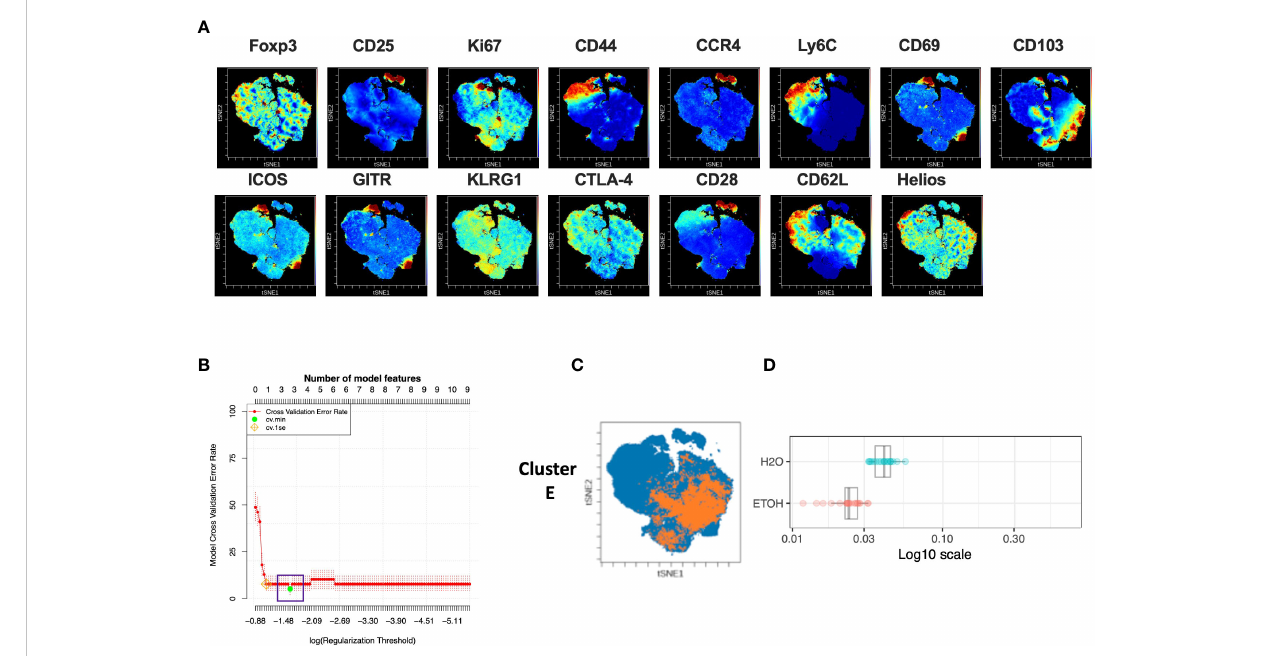
FIGURE 6 Combined CITRUS and viSNE analysis revealed one CD8 + T cell cluster associated with alcohol-drinking mice. (A) CD8 + T cell subset samples from the modeling cohort were equally downsampled to 20000 events to detect 2% subpopulations with CV=5%. 1 water drinking sample was excluded due to insuf fi cient event count. viSNE mapping was performed using all 15 available markers for clustering (CD3, CD4 and CD8 were excluded). Iterations were set to 7500, perplexity 70 and theta 0.5. This process was repeated to create two total viSNE maps, one of which was concatenated and displayed above. (B) CITRUS analyses was performed on the events comprising each viSNE plot. Samples were grouped by alcohol versus water exposure, the same 14 channels used for viSNE were selected for clustering by abundance. LASSO modeling was selected, minimum cluster size was set to 2%, false discovery rate 1% (note: this is irrelevant for LASSO), cross validation folds 10, and scales were normalized. The CV.MIN output was selected from the LASSO analysis. This process was repeated 3 times for each of the two viSNE maps yielding 6 total CITRUS replicates. A representative model error rate plot is show. (C) 6 CITRUS replicates were compared using the “ clusters-cv_min ” output fi le histograms. 1 cluster predictive of alcohol versus water drinkers was present across all replicates Cluster (E) and was selected for for downstream analyses. Representative clusters from one CITRUS run were concatenated and individually overlaid onto their corresponding viSNE plot shown in (A) . (D) Representative CITRUS feature plot corresponding to (C) showing differences in cluster frequency between alcohol and water exposed